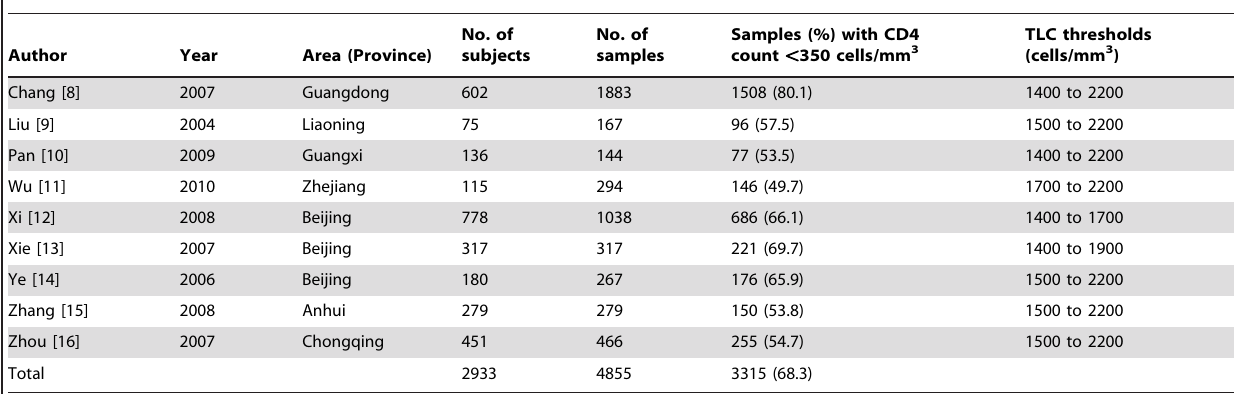
Table 2. Data from articles included in the literature review.